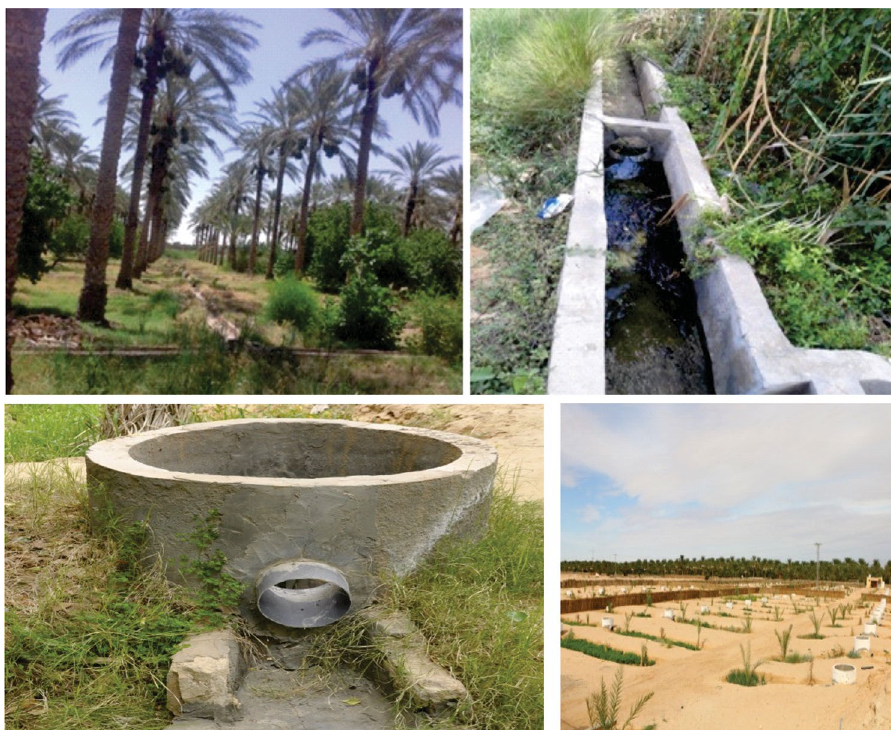
Fig. 11 Irrigation system on the study